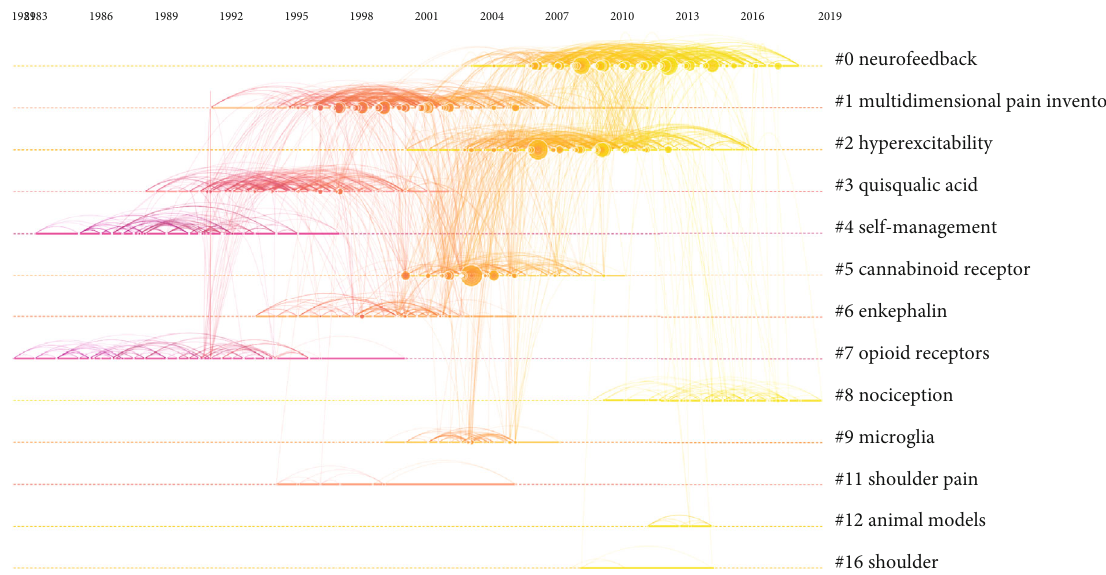
Figure 11: The analysis of references. Cocitation map (timeline view) of references from publications on pain after spinal cord